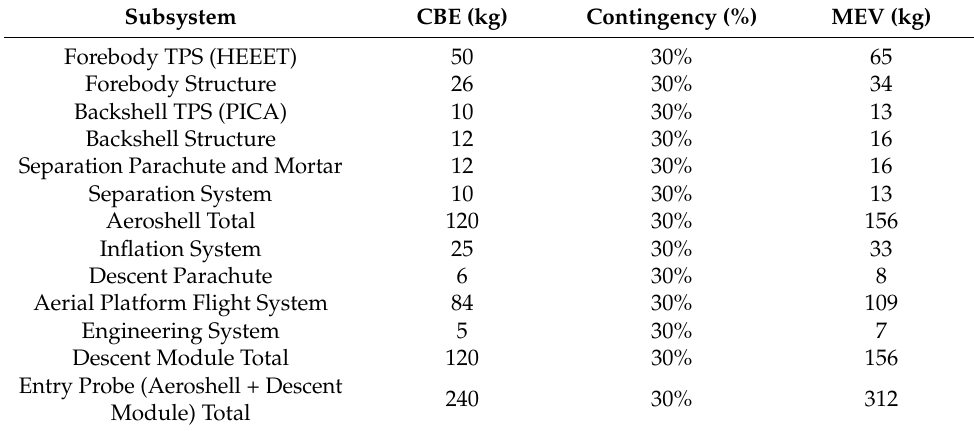
Table 6. Mass breakdown of the aerial platform.